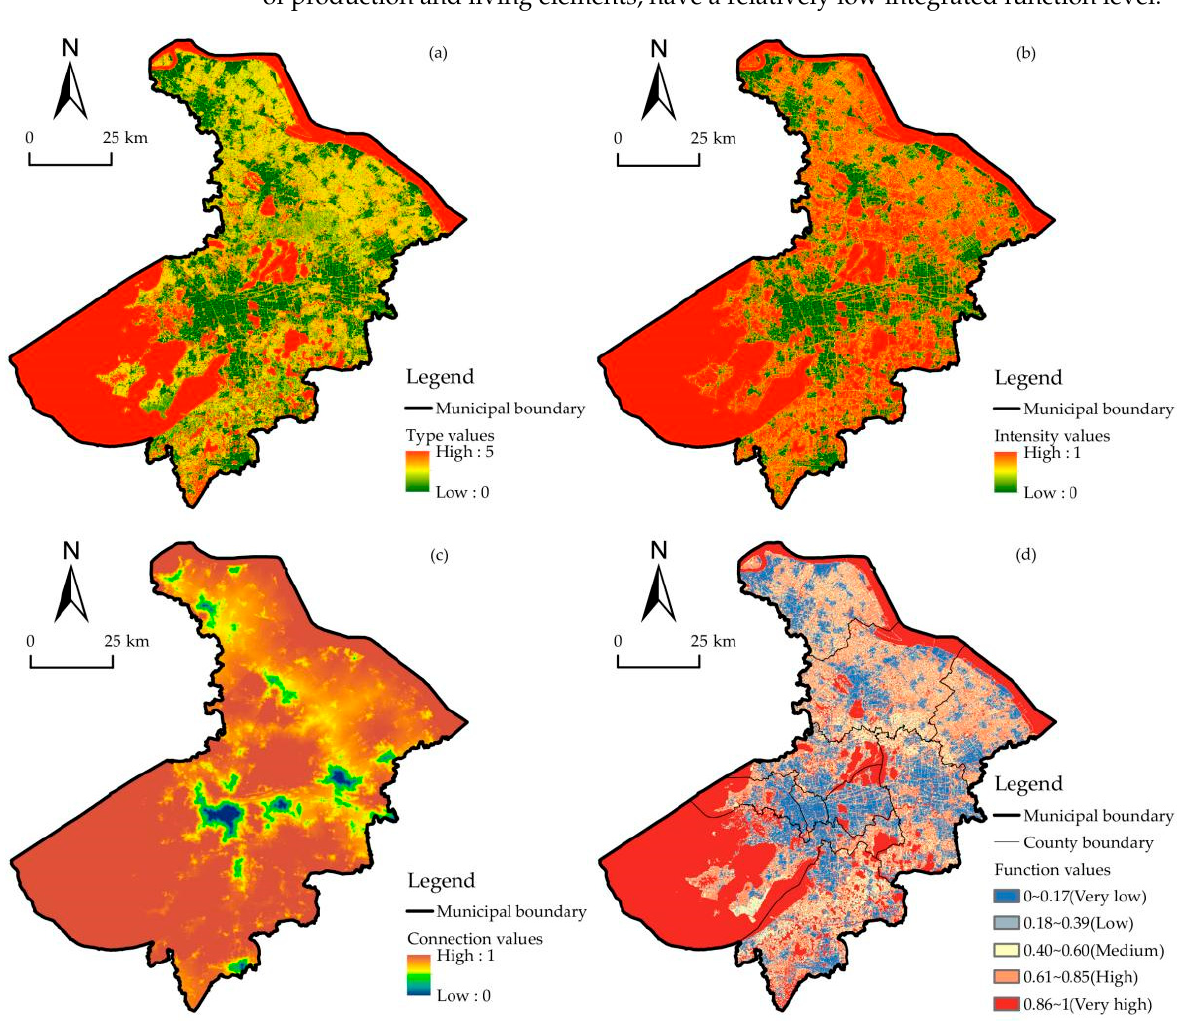
Figure 5. Functional level of ecological space: ( a ) Spatial type; ( b ) Spatial intensity; ( c ) Spatial connection; ( d ) Spatial function.